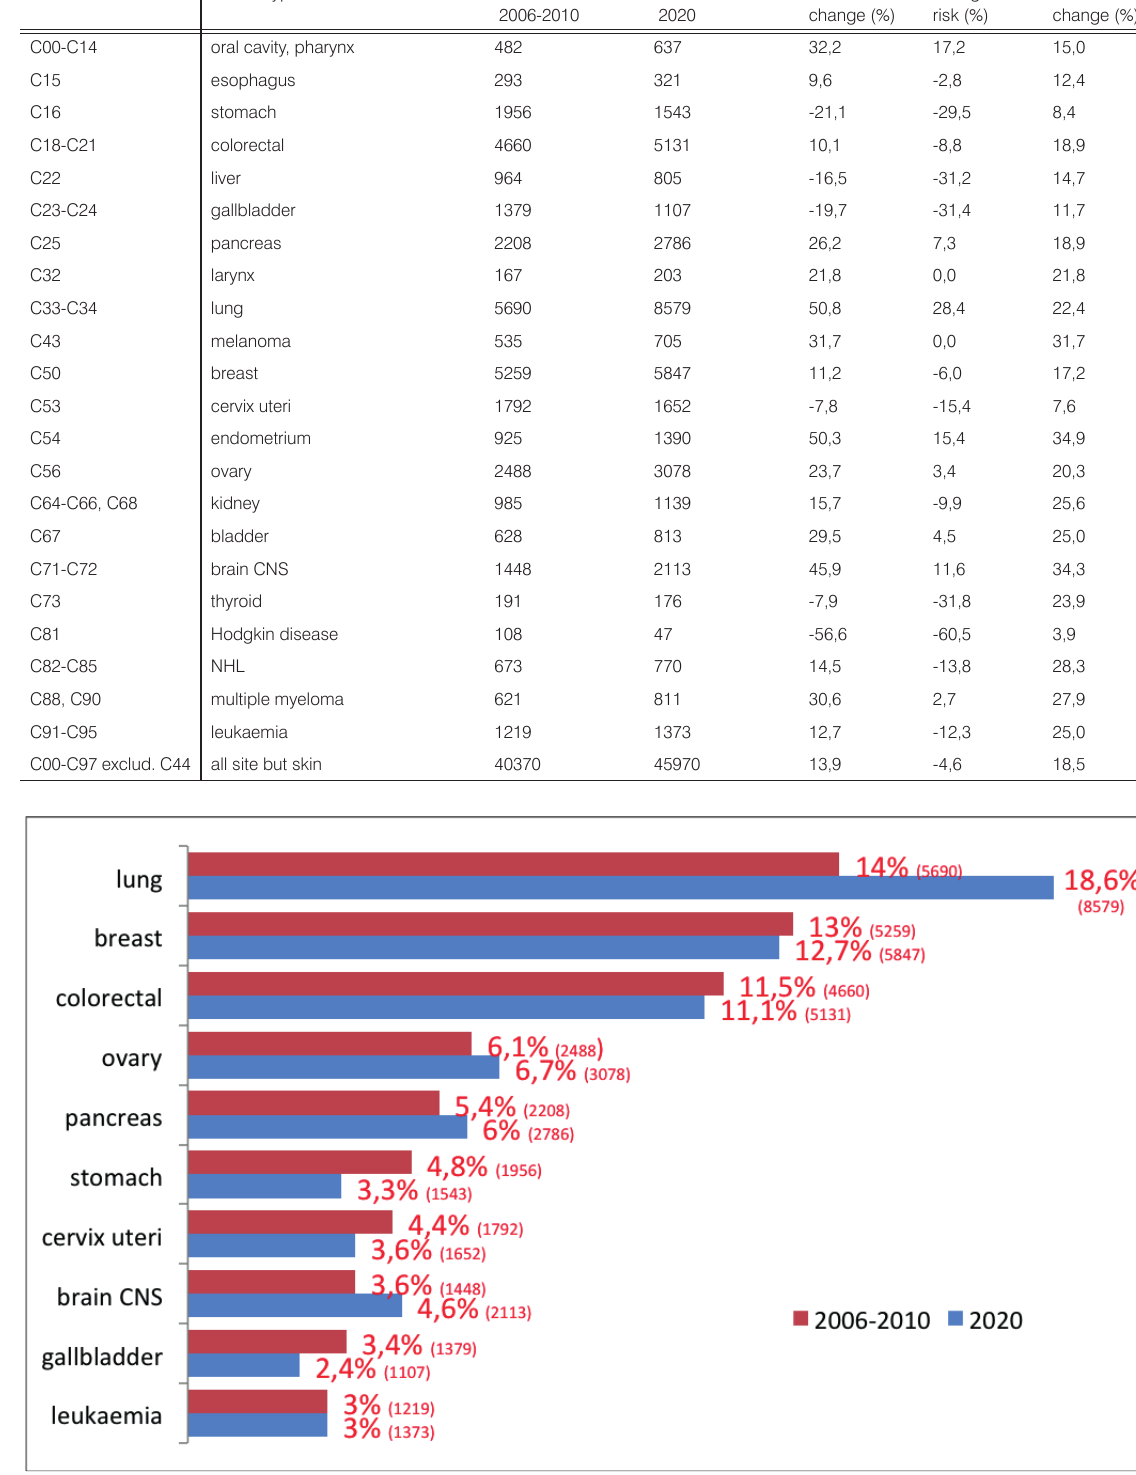
Figure 4. The structure of cancer mortality in females in Poland, 2006-2010 and 2020